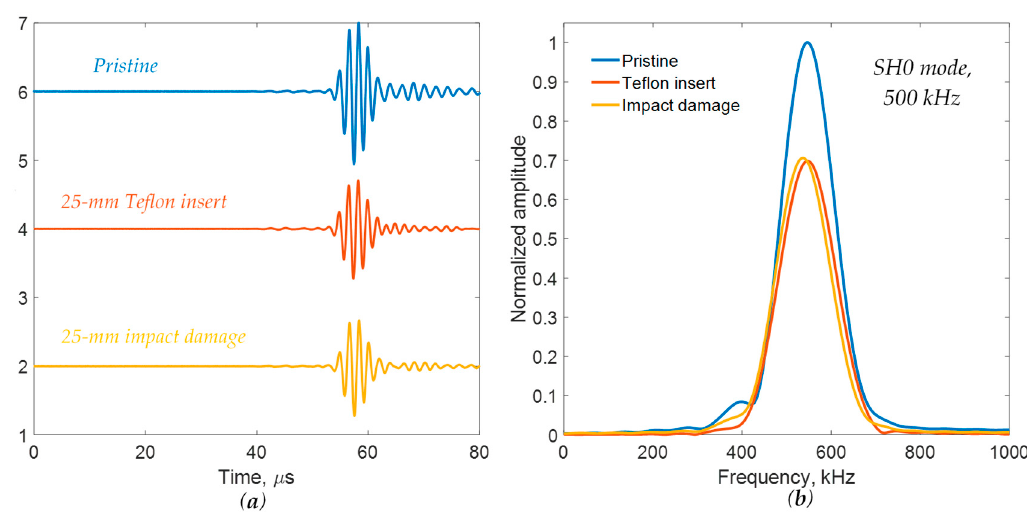
Figure 24. Signal comparison between the pristine area, the Teflon insert, and the impact damage using pure SH0 mode at 500 kHz on a 3-mm quasi-isotropic composite plate: ( a ) time-domain signals; ( b ) frequency spectrums.